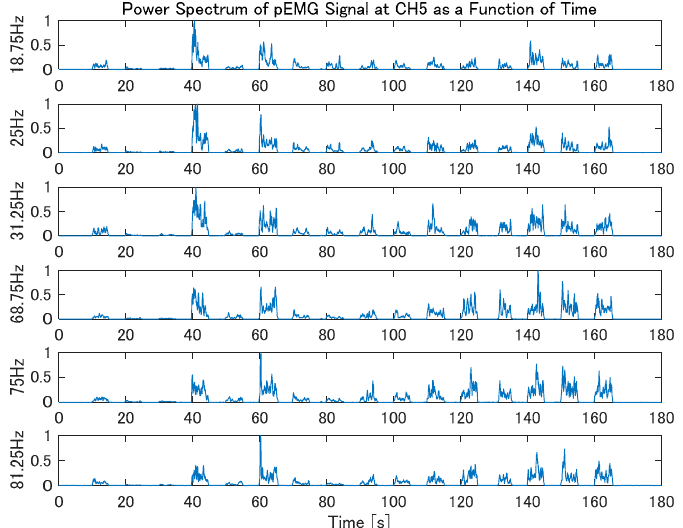
Figure 7. An example of PSDs prior to log transform of 17 motions shown as a function of time. The PSDs are derived from pEMG signals on channel 5. In order from the top, PSDs at 18.75 Hz, 25 Hz, 31.25 Hz, 68.75 Hz, 75 Hz, 81.25 Hz. Note that the PSDs are normalized for better visualization.